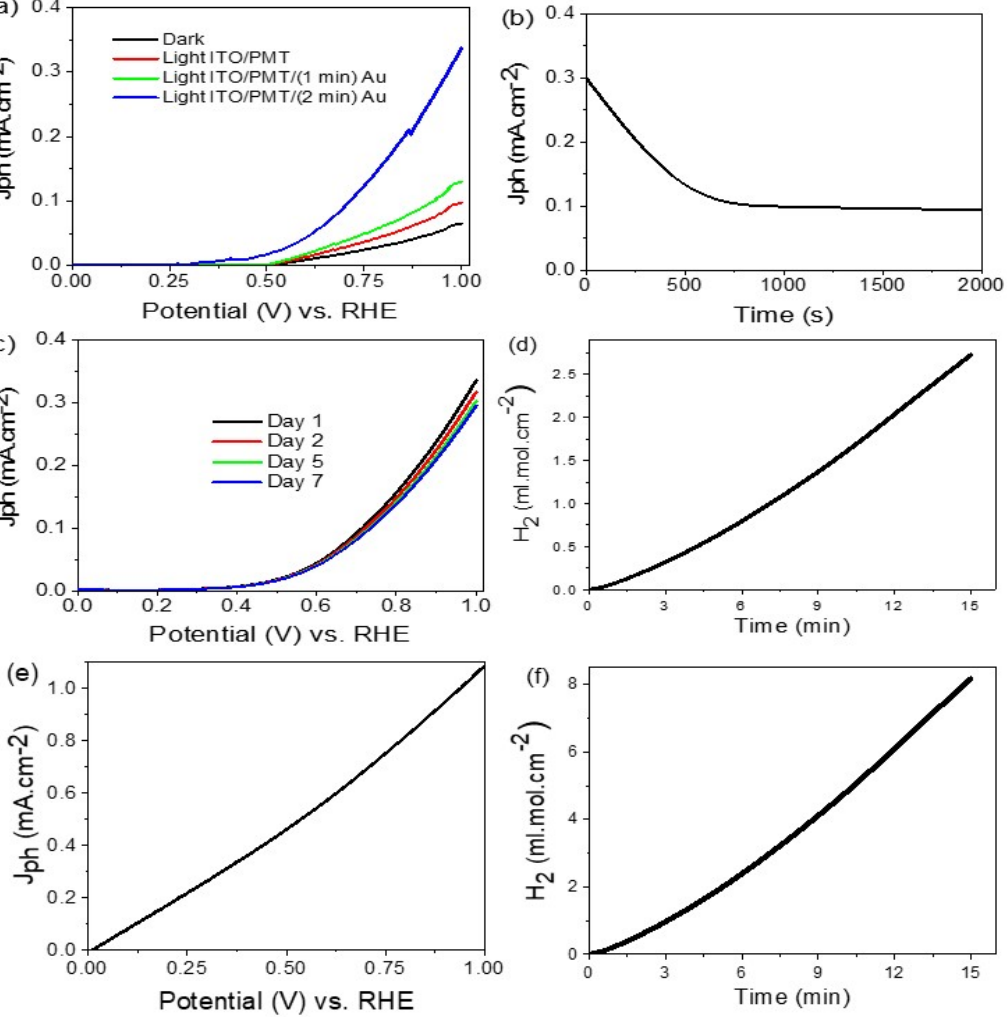
Figure 6. ( a ) Photocurrent voltage curves in dark (black) and under illumination for the ITO/PMT(red), ITO/PMT/Au-1 min (green), and ITO/PMT/Au-2 min (blue) electrodes; ( b ) current– time curve for the ITO/PMT/Au-2 min electrode at 0.75 V; ( c ) current–voltage characteristics for ITO/PMT/Au-2 min electrode under 7 days of illumination with a 400 W metal-halide lamp at 293 K; and ( d ) the evaluated H 2 moles at room temperature for ITO/PMT/Au-2 min using the Na 2 S 2 O 3 electrolyte. Sewage water ( e ) current–voltage characteristics for PMT/Au-2 min and ( f ) lifetime. The small dark current density (J o ) for the ITO/PMT/Au-2 min electrode is related to the flow of electrons through the PMT and Au